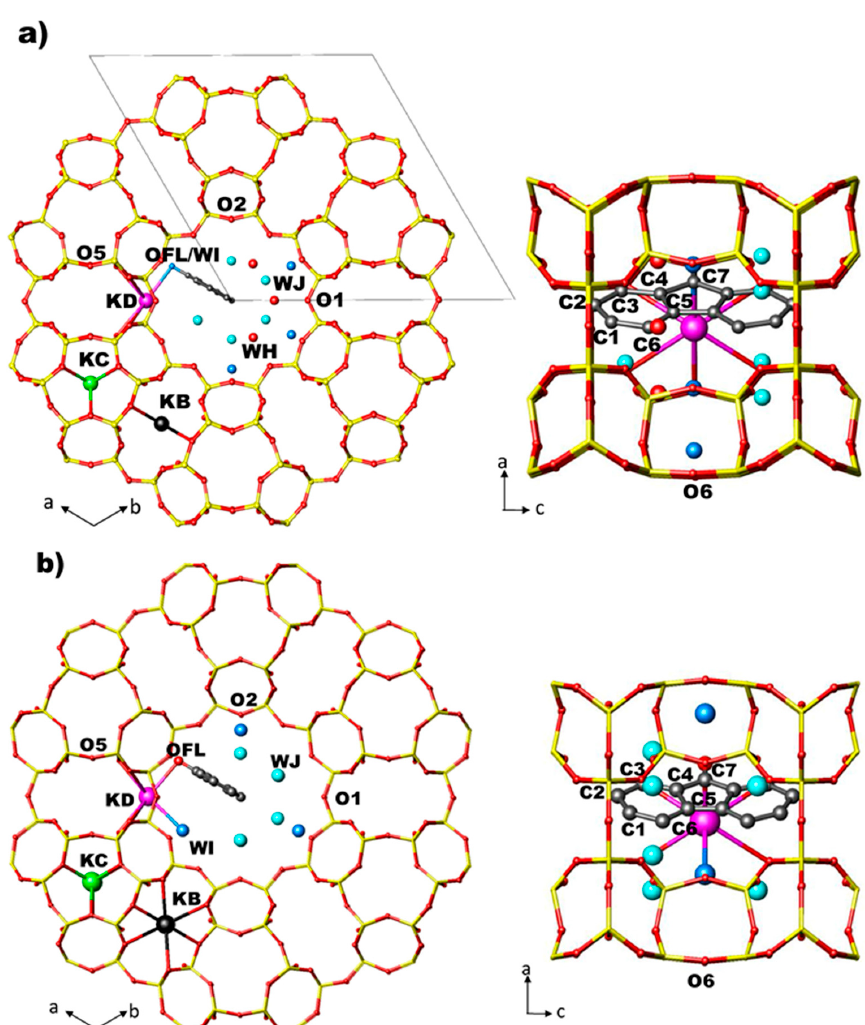
Figure 6. Arrangement of FL and water molecules in the 12 MR channel along [001] and along [010] directions in the ZL/0.5FL and ZL/1.0FL composites ( a , b ) at 2 GPa, as obtained by Rietveld re fi nements. Table 2. Experimental framework distances obtained from the refinements performed on the ZL/0.5FL and ZL/1.0FL composites at P amb (from Ref.[56]), at 2 GPa and upon decompression ( P amb (rev)). 1 From ref. [56].